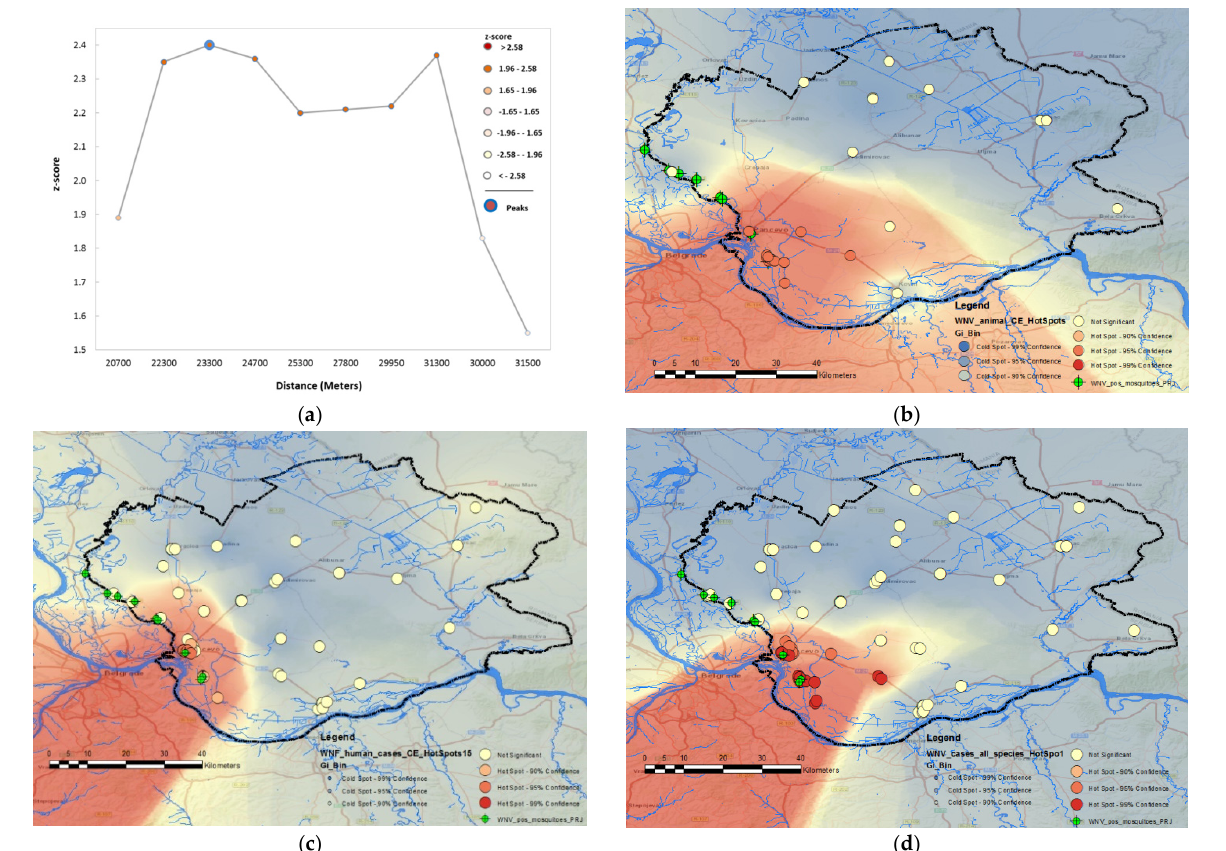
Figure 8. Geospatial hot spot analysis of the formation of “hot” spots of cases of WNV infection in animals and humans in 2017, 2018, and 2019: ( a ) Global spatial autocorrelation analysis of WNV outbreaks (Global Moran’s I test); ( b ) WNV hot spot analysis of cases of infection in animals; ( c ) WNV hot spot analysis of human cases; ( d ) combined WNV hot spot analysis of infection in humans and animals.